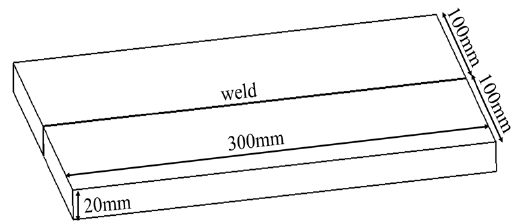
Figure 3. Welding method of test plate.